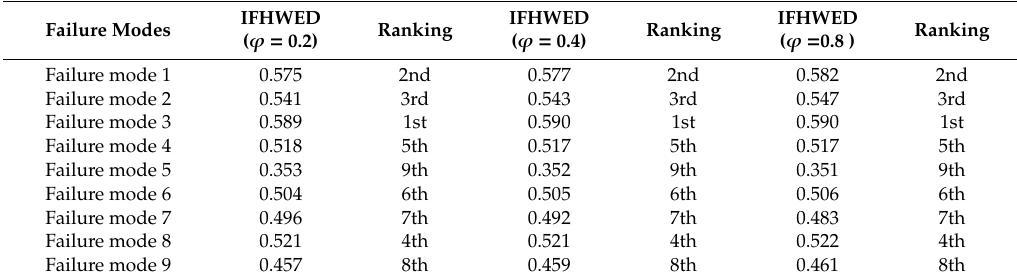
Table 16. Sensitivity analysis.